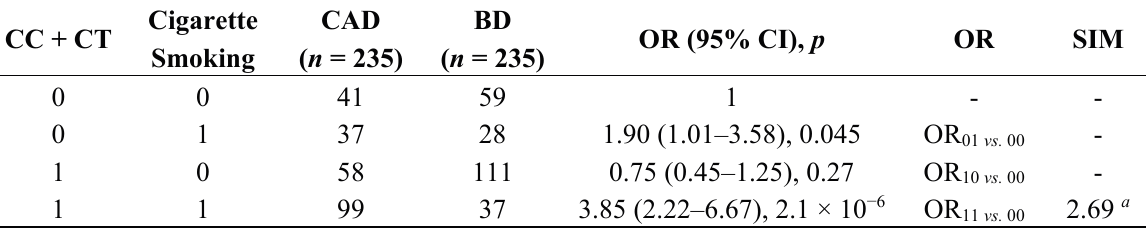
Table 5. Synergistic effect between C allele carrier state of the USF1 gene rs2516839 polymorphism and cigarette smoking exposure.